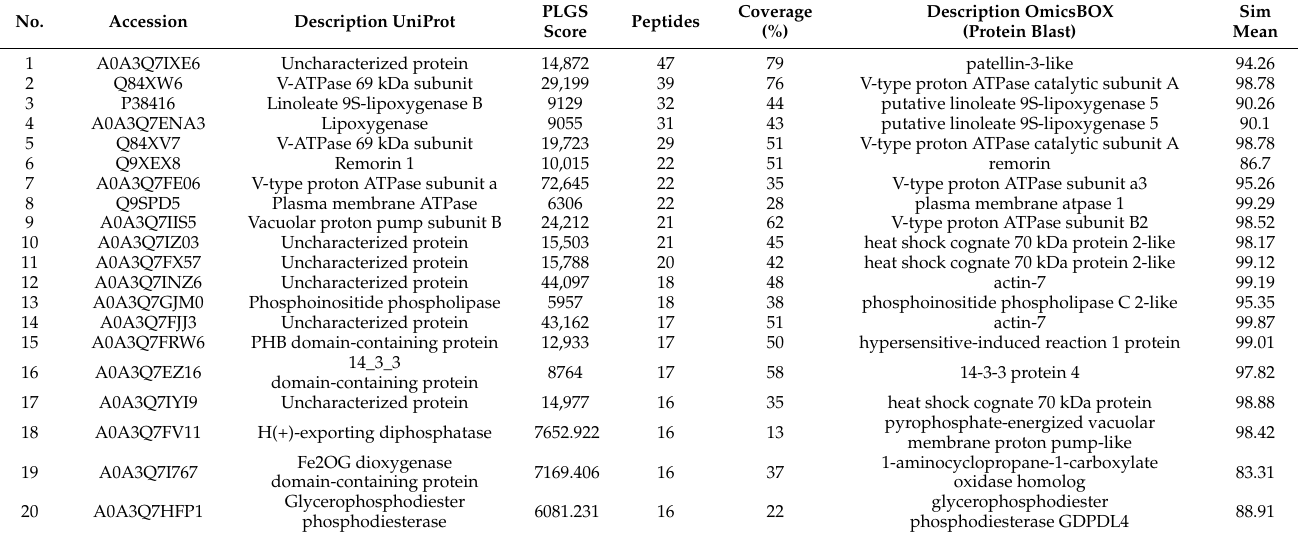
Table 1. Top-ranking proteins’ functional annotations of tomato nanovesicles (NVs) isolated by iodixanol gradient density ultracentrifugation as low-density band (Fraction